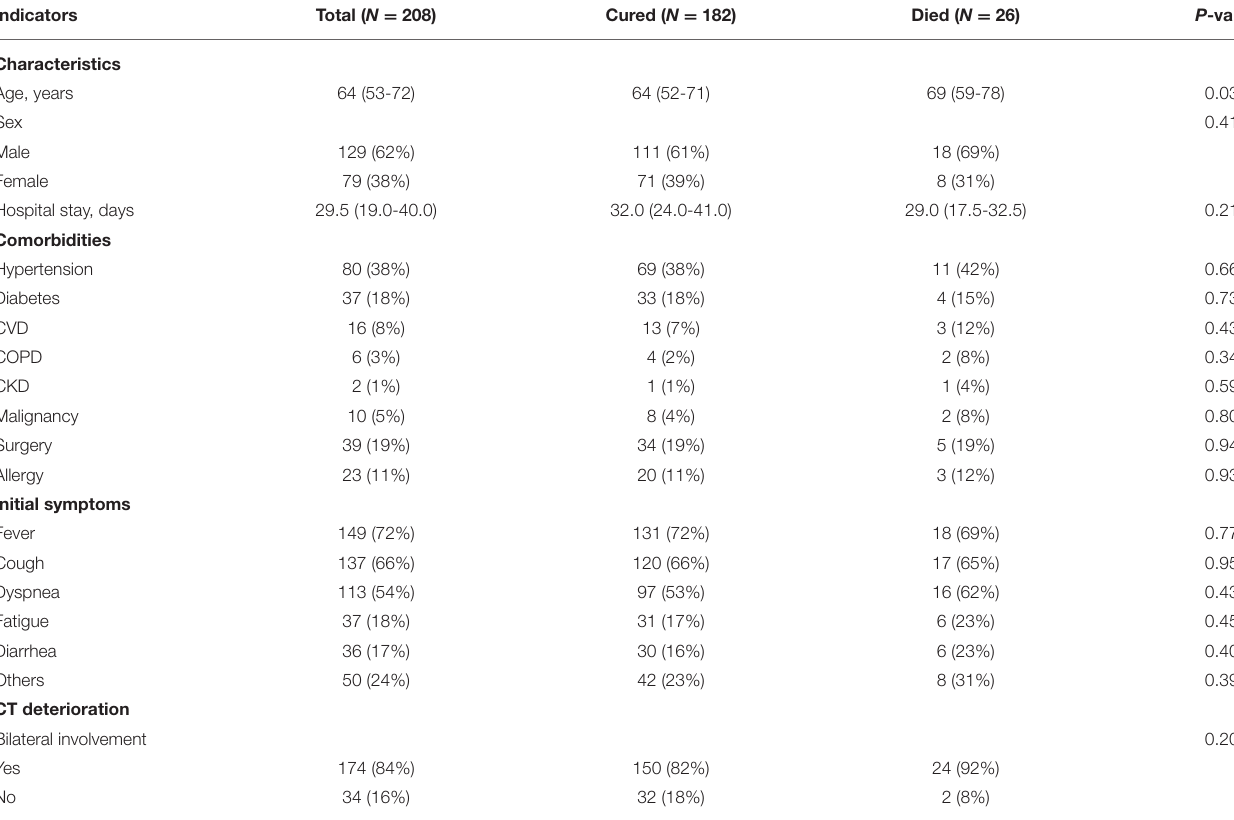
TABLE 1 | Demographic and clinical findings of COVID-19 patients included in the study. Indicators Characteristics